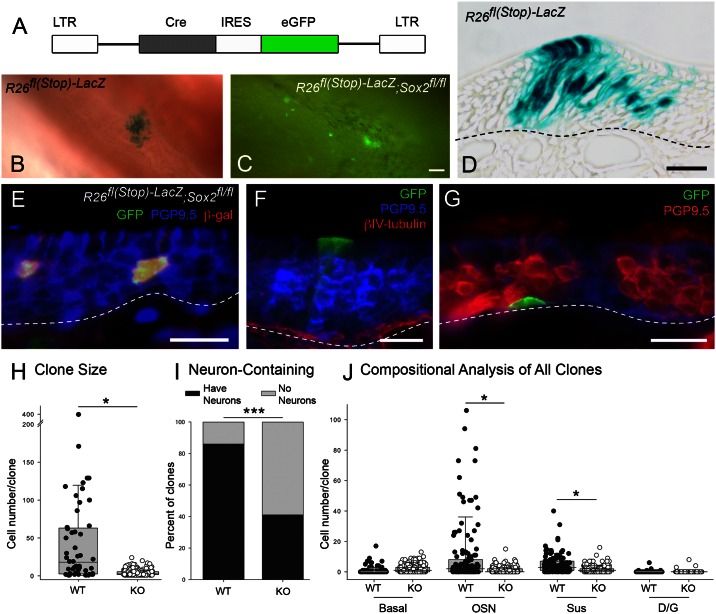
Conditional deletion of Sox2 by way of RVV transduction produces smaller clones that contain fewer neurons than control.(A) Cartoon illustration of retroviral construct used for transduction with Cre recombinase. (B, C) Representative clones from whole mount tissue harvested 3 weeks after infection. (B) X-gal staining demonstrates the typical clone size from control R26fl(stop)-LacZ indicator mice transduced with Cre. (C) GFP fluorescence expressed from the RRV, demonstrates the typical clone size from Sox2flox/flox transduced mice. (D) Representative histological section stained to detect β-galactosidase activity within a clone following Cre-transduction in a R26fl(stop)-LacZ control mouse; note the large numbers of neurons, which are situated broadly along the middle of the epithelium. (E-G) Representative sections from Cre/GFP-expressing clones in Sox2flox/flox mice that have been immunostained to characterize clonal composition. Dashed lines mark the basal lamina. (H) The range in the number of cells/clone is depicted in the form of a box-and-whiskers scatter plot, and the horizontal black line within the box indicates the median clone size, where the median values were 19 and 3, respectively. The distributions are significantly different (Mann-Whitney-U test, *** p < 0.001). (I) The proportion of infected clones containing neurons or not is depicted in the form of a stacked bar graph, gray and black respectively. The proportions are significantly different between wildtype and knockout (Z test, *** p < 0.001) (J) Compositional analysis plotting the number of the different types of cells in each clone, by a box-and-whiskers scatter plot; median clone size is indicated with a black line. Median values for control vs. knockout for basal, OSN, Sus, and D/G are 0 vs. 1, 2 vs. 0, 3 vs. 1, and 0 vs. 0, respectively. Note that both the number of neurons and the number of Sus cells are significantly reduced by Cre-mediated recombination in floxed Sox2 mice as shown by Dunn’s method for pairwise comparisons (indicated by the horizontal lines, * p < 0.05). Scale bar in (C) corresponds to 50 μm and also applies to B, scale bars in D-G correspond to 10 μm.